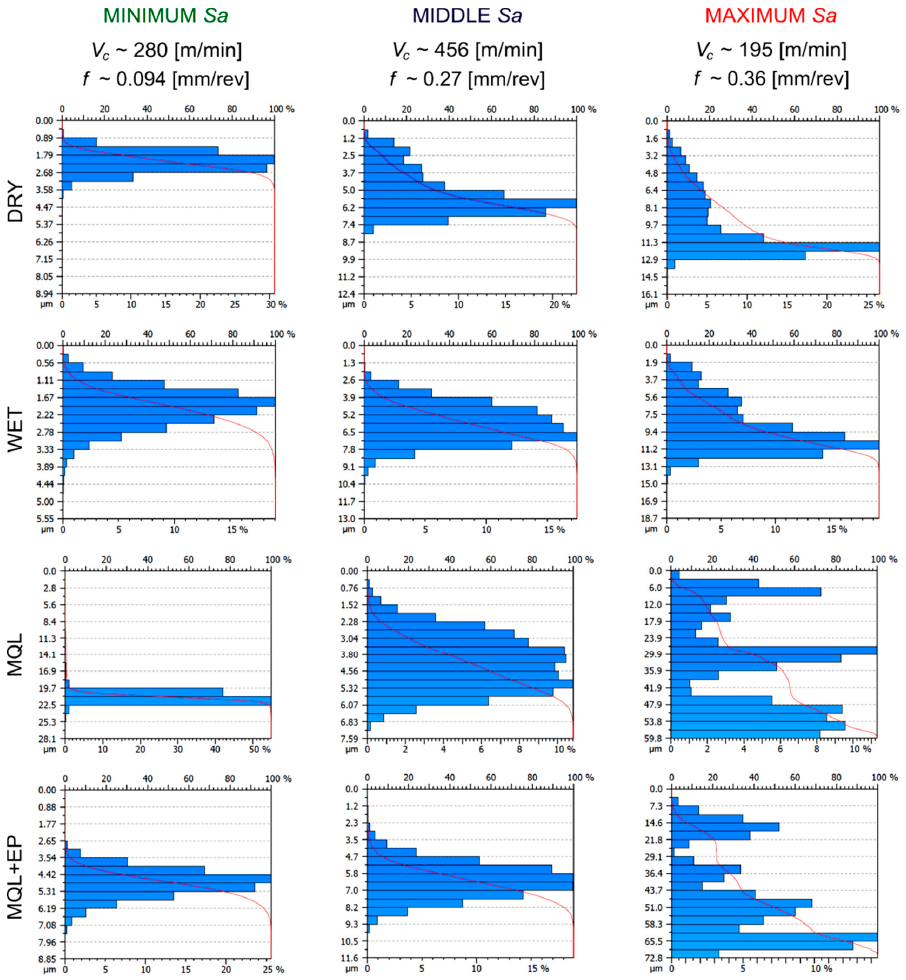
Figure 13. Material ratio curves and distributions of peak heights after finish turning of the steel